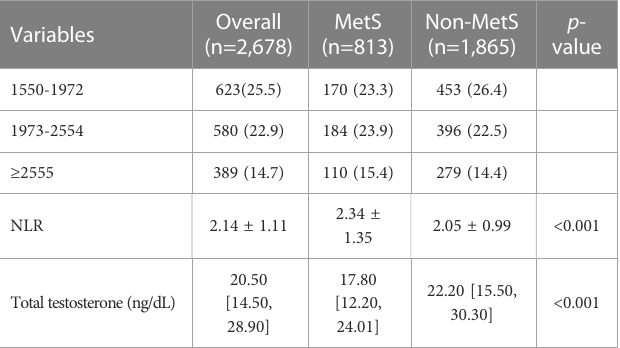
TABLE 1 Characteristics of study participants in the NHANES 2011-2016 * .